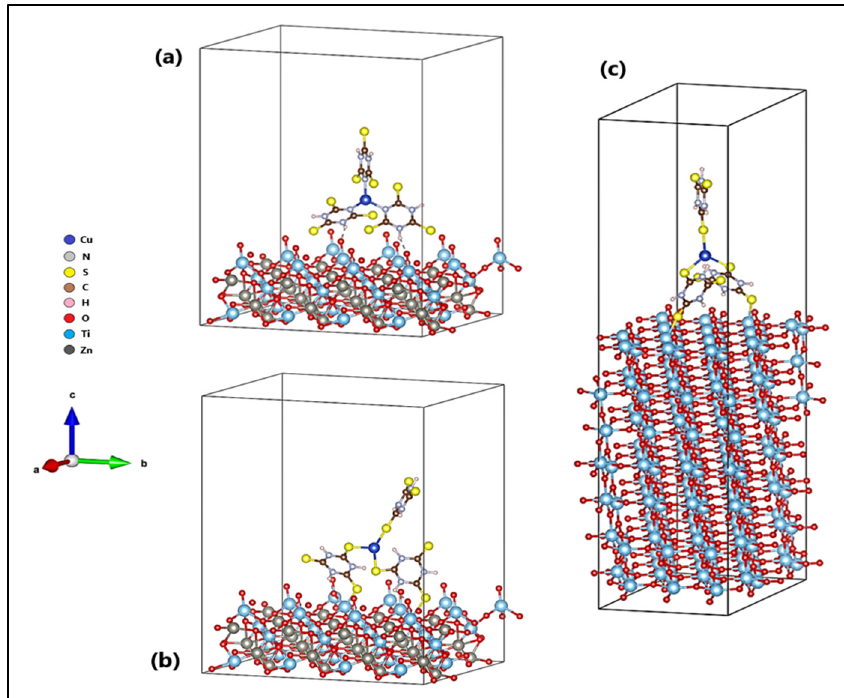
Figure 11. Cu-TTC molecule in ( a ) n -Cu-TTC and ( b ) s -Cu-TTC tautomeric form on the ZnTiO 3 surface, and ( c ) s -Cu-TTC tautomeric form on the TiO 2 surface. The anchoring models of the s -Cu-TTC molecule on the ZTO and TO surfaces are displayed in Figure 12. Adsorption of the Cu-TTC complex on the ZTO and TO surfaces arises in a bidentate adsorption model with one sulfur atom from each surface-facing triazine ring bound to the nearest titanium atom.